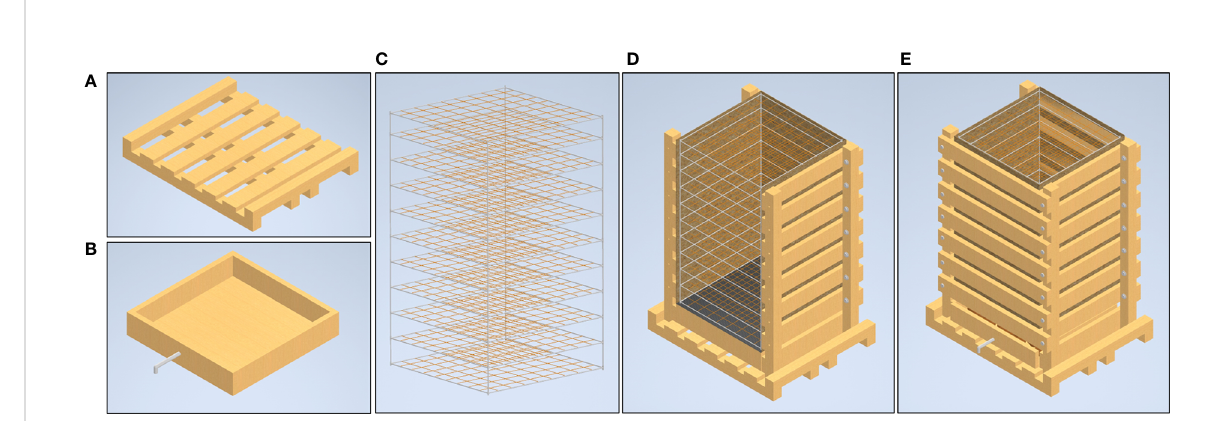
FIGURE 1 Major structural components of the mesocosm system. The mesocosm base is constructed from pressure treated lumber and designed for easy movement by a pallet jack (A) . Directly above the base is a drainage box equipped with a drain spout to facilitate fl ow-through irrigation and allow sample collection (B) . The internal component of the mesocosm is a scaffold system constructed of 0.5 inch PVC and fi shing line (C) . The exterior mesocosm walls are composed of lumber and held together with galvanized bolts (D) . Between the internal frame and external lumber are thin boundaries of masonite that form smooth interior surfaces and a tarp to hold water in. The boards on the outside of the mesocosm can be attached and removed for easy access to the interior scaffold after roots have been grown (E)